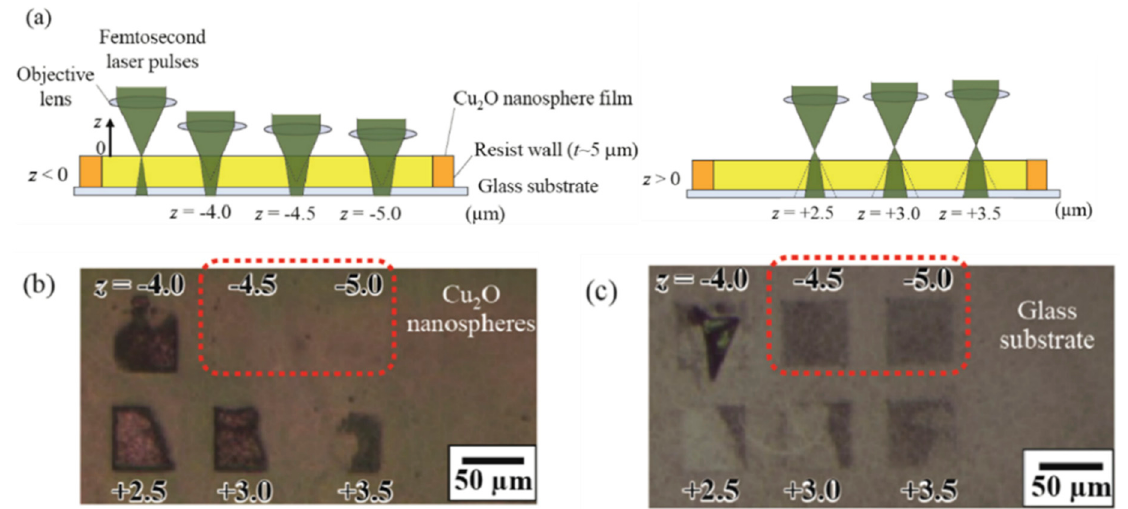
Figure 10. ( a ) Schematic of microfabrication of Cu-based patterns within a Cu 2 O film. Microscopic images of ( b ) sintered patterns and ( c ) after Cu 2 O nanosphere film removal (Adapted from reference [158]).